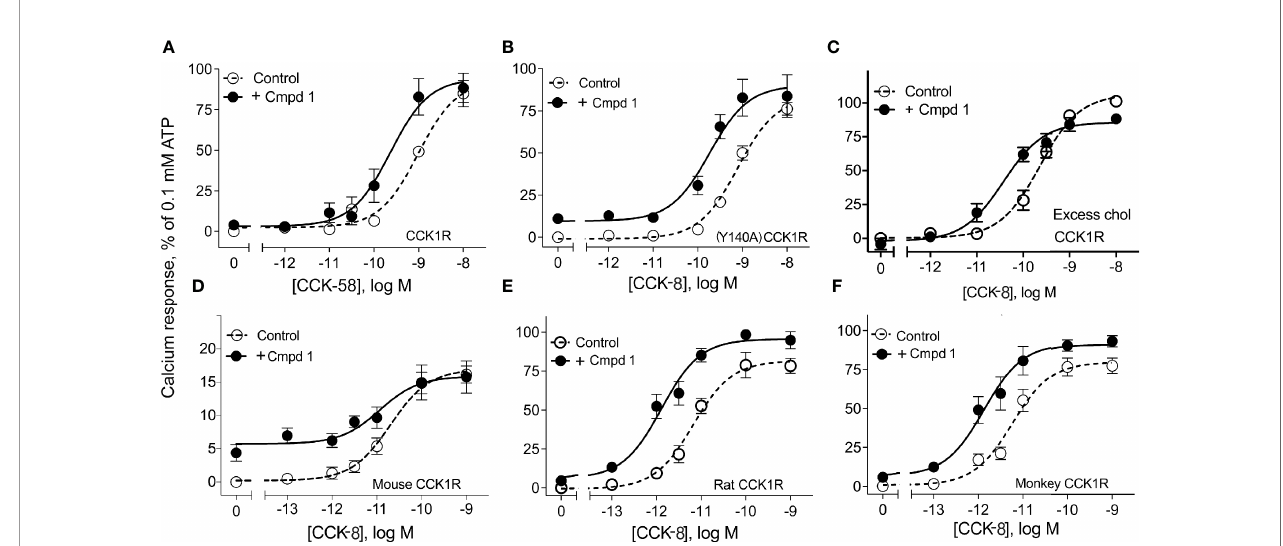
FIGURE 2 | Effects of Compound 1 on CCK-stimulated intracellular calcium responses at CCK1R in normal and high cholesterol and at various species of CCK1R. Shown are the effects of 10 µM of Compound 1 on CCK-peptide-stimulated intracellular calcium responses ( Table 1 ). Human CCK1R constructs are studied in (A – C) , with mouse CCK1R in (D) , rat CCK1R in (E) , and Cynomolgus monkey CCK1R in (F) . Data in (A) show impact on stimulation by CCK-58, the dominant form of this hormone in the human circulation. Data in (B) show impact on a CCK1R mutant, (Y140A)CCK1R, previously shown to mimic this receptor in a high cholesterol environment. This cell line exhibited higher af fi nity for CCK than WT CCK1R [human CCK1R/human (Y140A)CCK1R: pKi for CCK-8, 8.9 ± 0.1/10.1 ± 0.3], with similar levels of receptor expression [human CCK1R/human (Y140A)CCK1R: receptor number × 10 5 sites/cell, 0.6 ± 0.1/0.5 ± 0.1]. Data in (C) show impact on effects of CCK-8 at wild-type CCK1R in cells in which cholesterol composition has been augmented. All of these are CHO cell lines stably expressing CCK1R. Values are expressed as percentages of the intracellular calcium responses to maximal stimulation achieved by 0.1 mM ATP and data points represent the means ± S.E.M. of data from a minimum of three independent experiments performed in